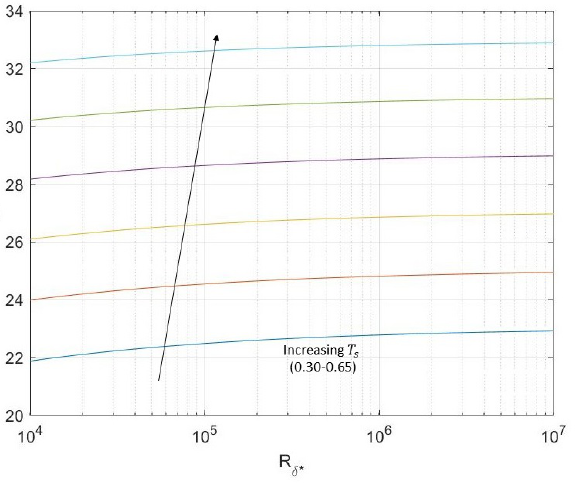
Figure 12. Plot illustrating predictions of asymptotic neutral waveangle φ against R δ ∗ for type I modes for T s = 0.30 − 0.65. Larger T s values move the plots up as shown by the